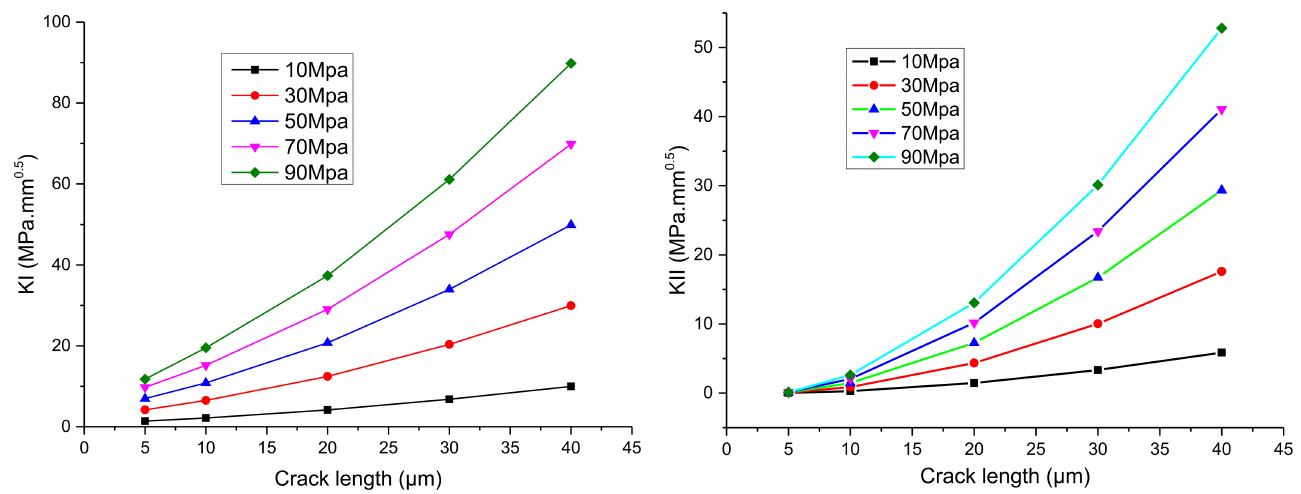
Figure 8. The relationship between the stress intensity factor of the interface crack between the IMC and the solder and crack